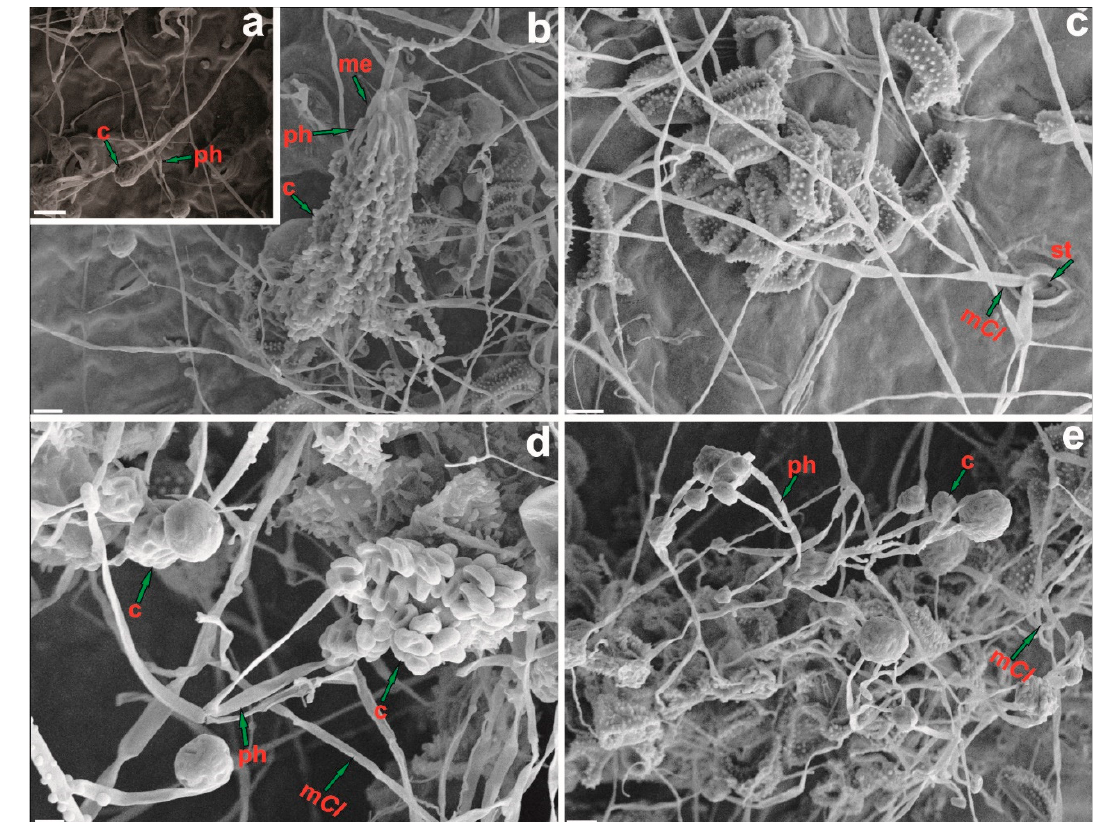
Figure 9. SEM photographs of Hemileia vastatrix uredinia inoculated with Chlonostachys spp. Asexual structures of Clonostachys spp. Note: primary conidiophore ( a , e ), secondary conidiophore ( b , d ), metulae (me), mycelium of Clonostachys (m Cl ), stomata (st), phialides (ph), conidium. ( c ) Evidence of mycoparasitism with Clonostachys spp. on urediniospores of H. vastatrix . Invasion of urediniospores by C. rhizophaga COAD 2979 ( b ), C. rhizophaga COAD 2982 ( d ) and C. byssicola COAD 2983 ( e ). Overgrowth of uredinia and evidence of emergence or entrance of C. rhizophaga COAD 2980 hyphae through stomata ( c ). Bars = 10 µm.